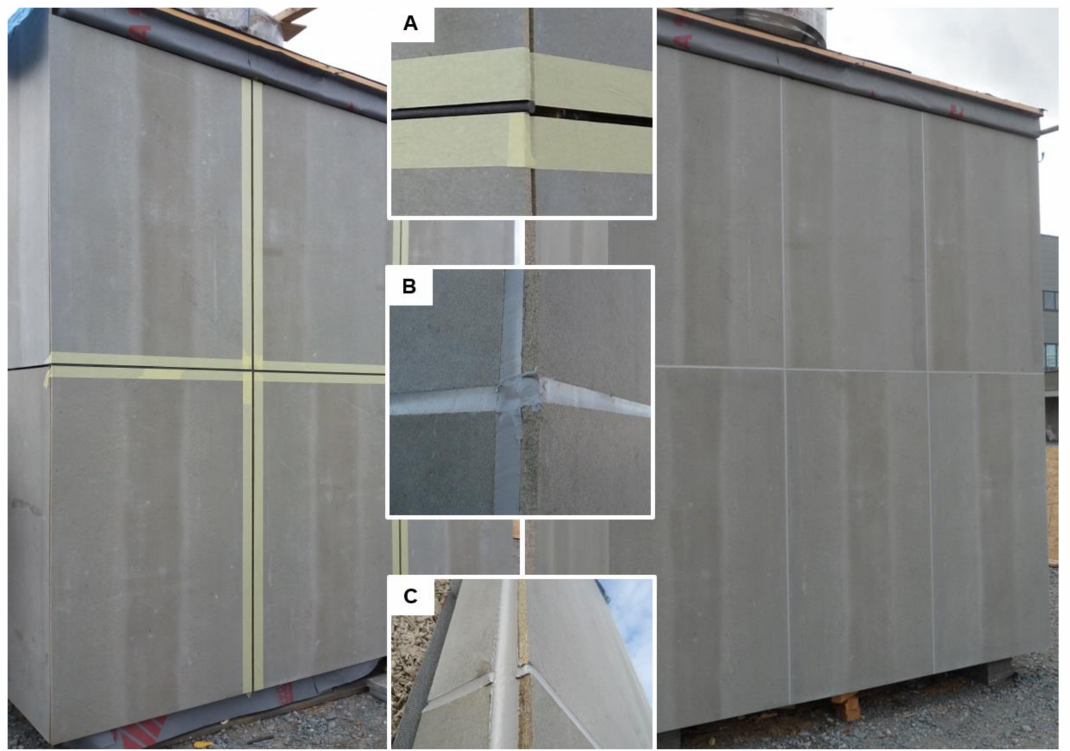
Figure 3. Experimental façade without ( left ) and with ( right ) sealed joints: ( A ) joint detail with backer rod, ( B ) and ( C ) detail of a connection of the horizontal and vertical